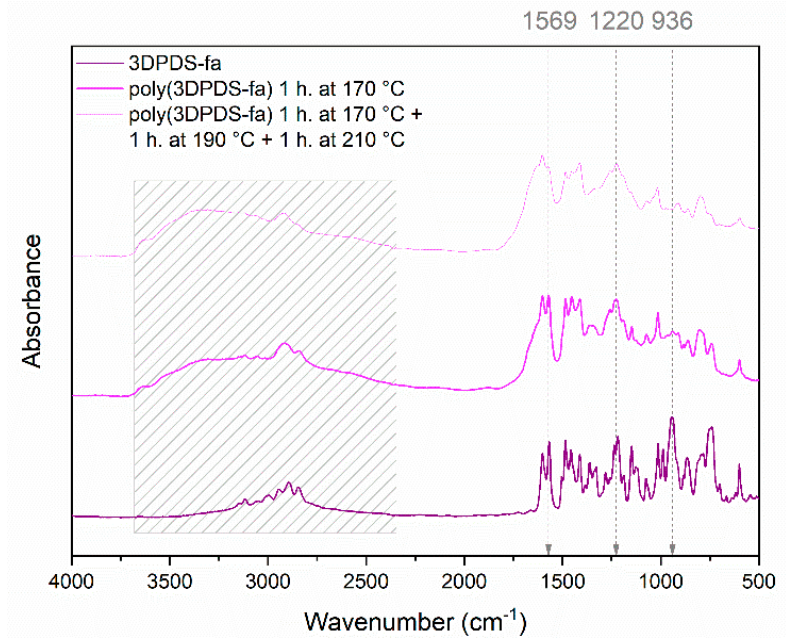
Figure A9. FTIR spectra of 3DPDS-fa, poly(3DPDS-fa) after curing at 170 °C for 1 h, and poly(3DPDS-fa) after curing at 170 °C for 1h and post-curing at 190 °C for 1h and 210 °C for 1 h.